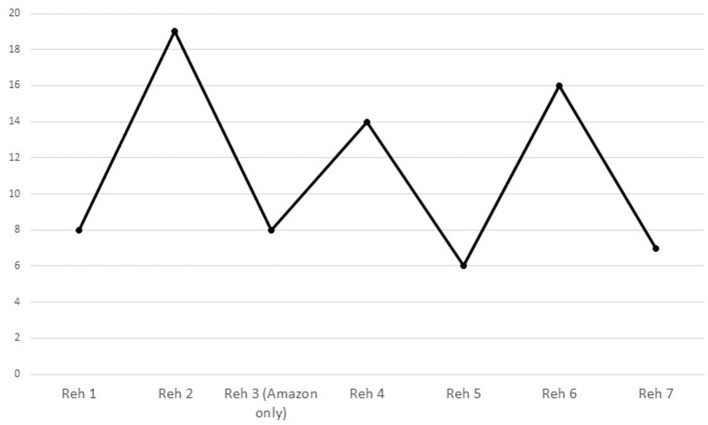
Utterances by both musicians showing solidarity in each rehearsal.